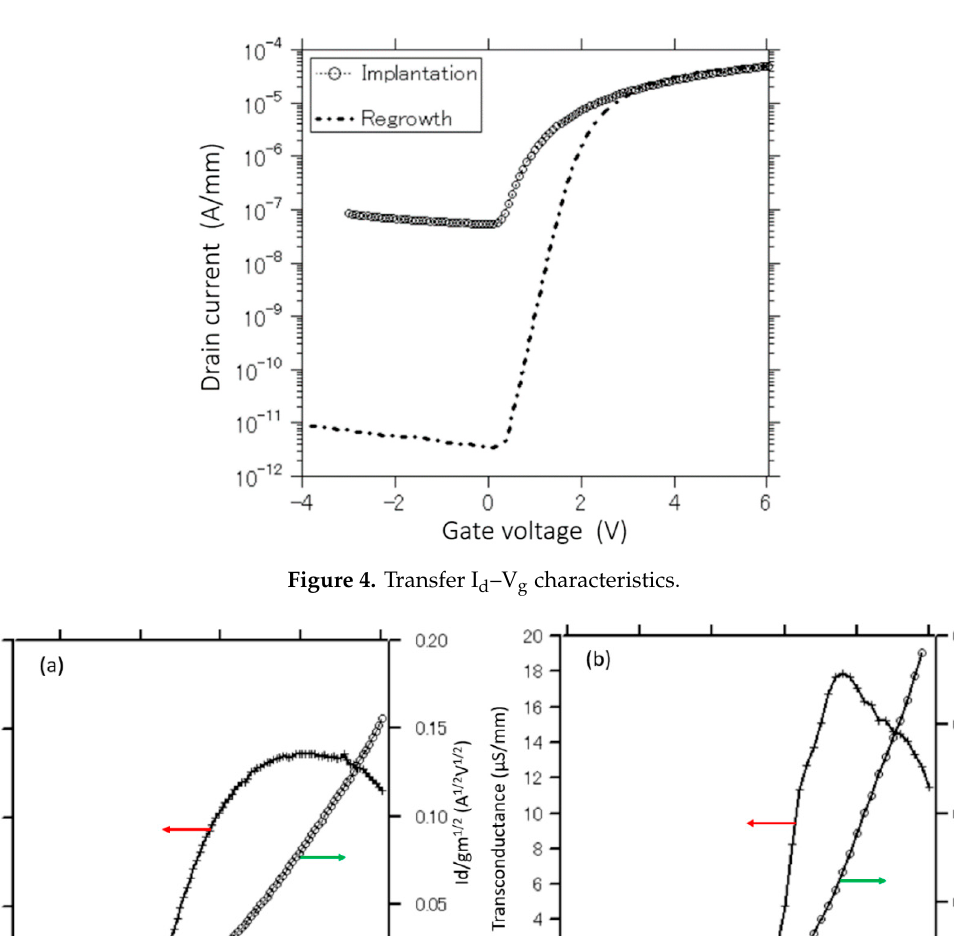
Figure 4. Transfer I d –V g characteristics.